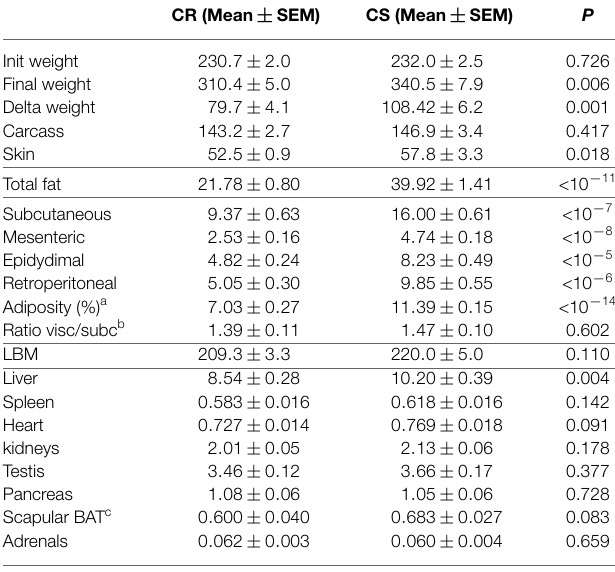
TABLE 3 | Body composition of the CR and CS rats (data in g except otherwise stated) .